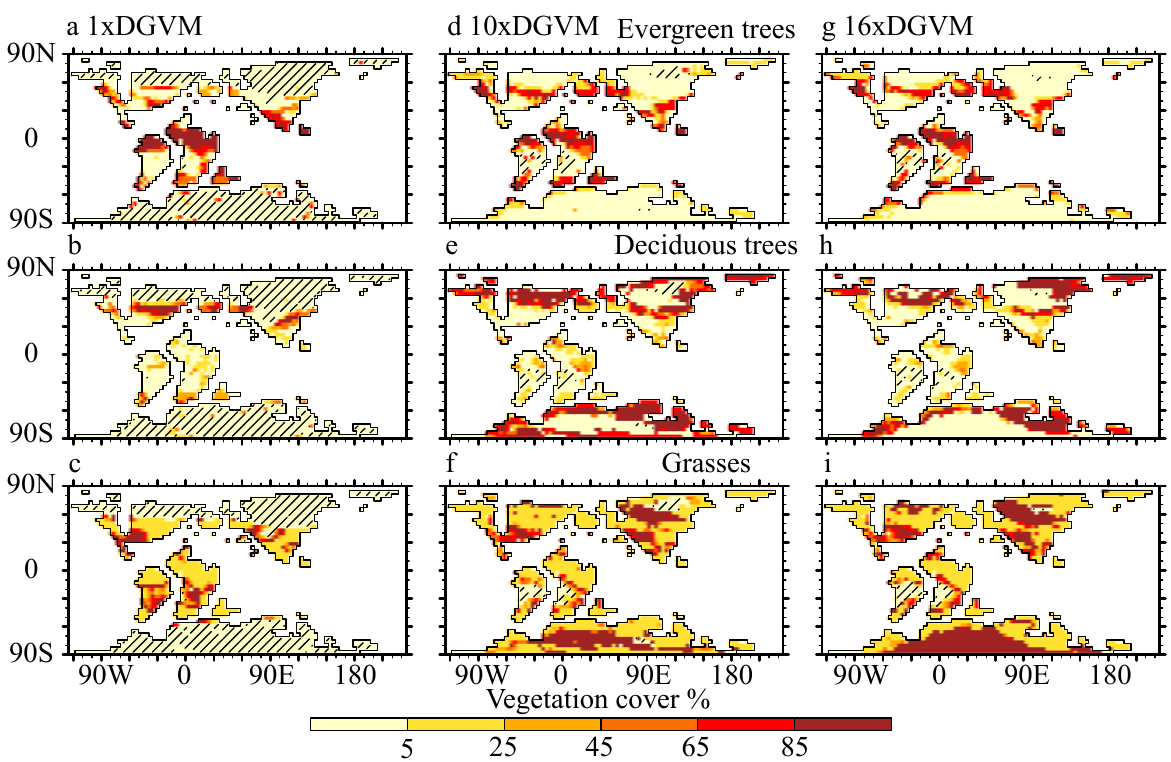
Fig. 2. Global distribution of evergreen trees (a) , (d) , (g) , deciduous trees (b) , (e) , (h) and grasses (c) , (f) , (i) (%) for the 1xDGVM, 10xDGVM, and 16xDGVM experiments, respectively. Land area with < 10% vegetation cover, which is defined as desert, is shaded. Note, hereafter, continental outlines delimit area with > 50% land cover. Evergreen trees include tropical and temperate broadleaf evergreen, and temperate and boreal needleleaf evergreen. Deciduous trees include tropical and temperate broadleaf deciduous and boreal